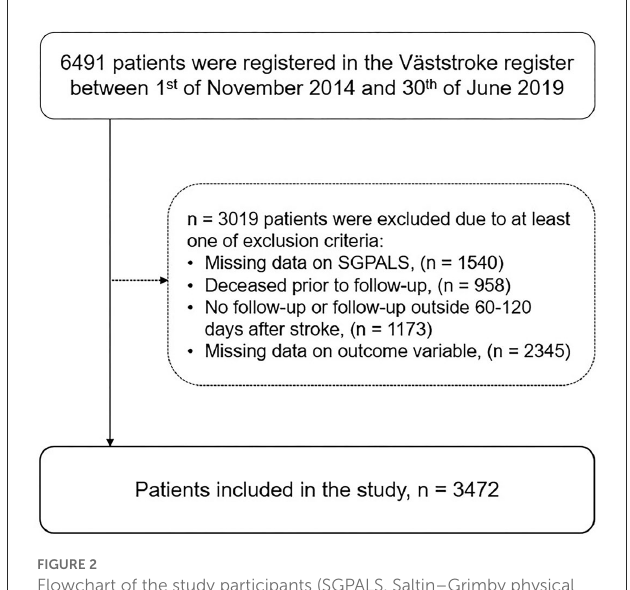
FIGURE2 Flowchart of the study participants (SGPALS, Saltin–Grimby physical activity level scale).